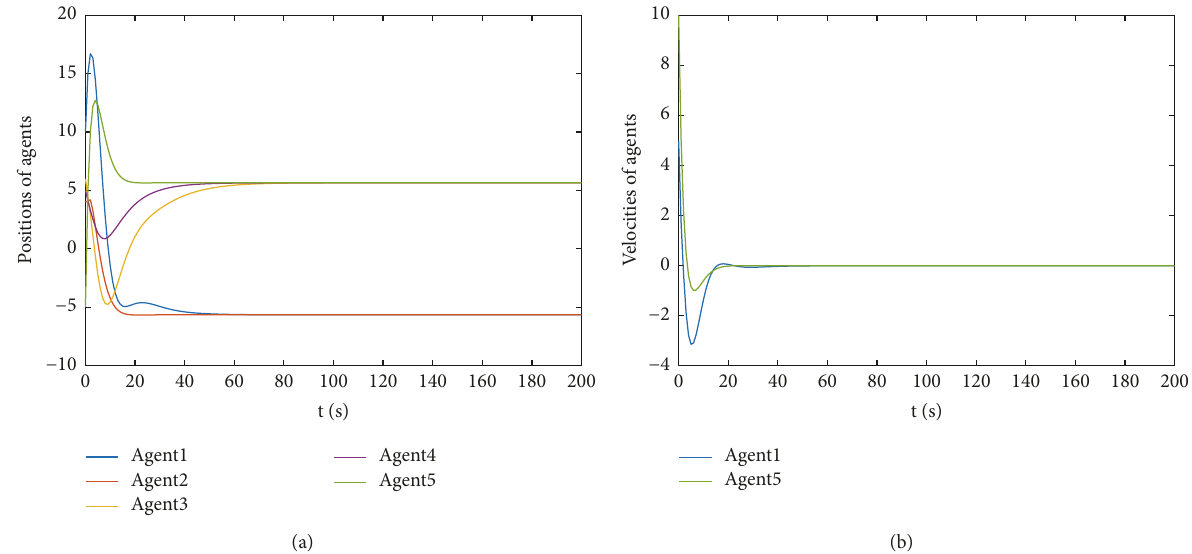
Figure 2: The state trajectories of the agents under directed topology in Figure 1 with identical input time delays 𝜏 = 0.5 , 𝜏 𝑖𝑗 = 1 . (a) Positions, (b)